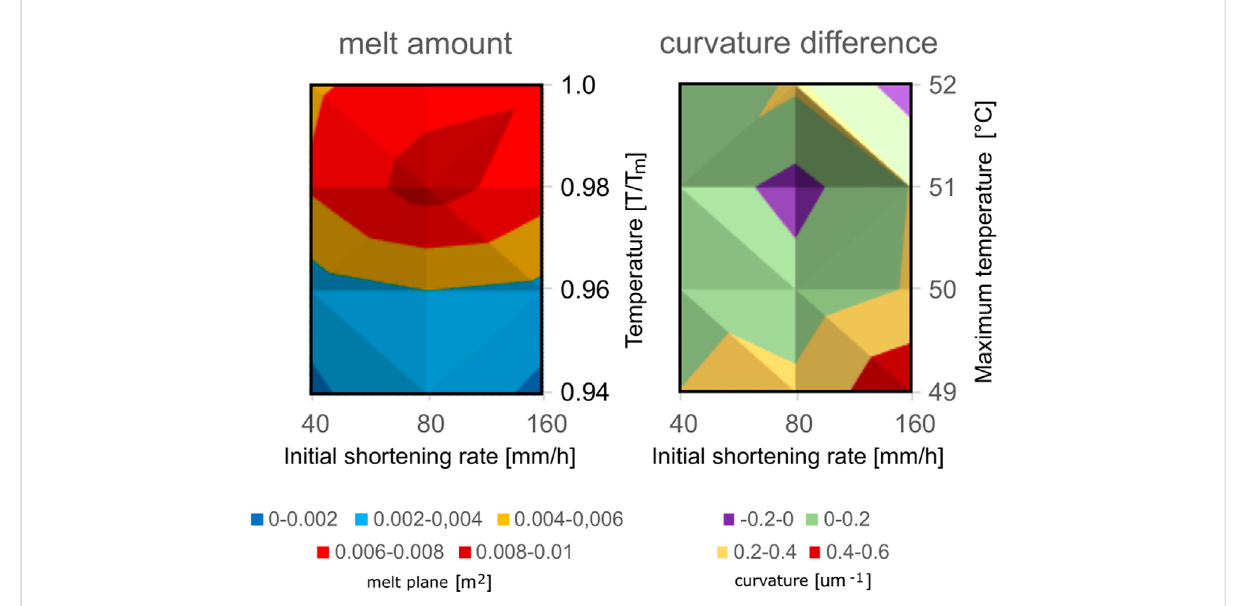
FIGURE 5 The contour plots of the melt amount and curvature difference corresponding to the initial conditions of investigated